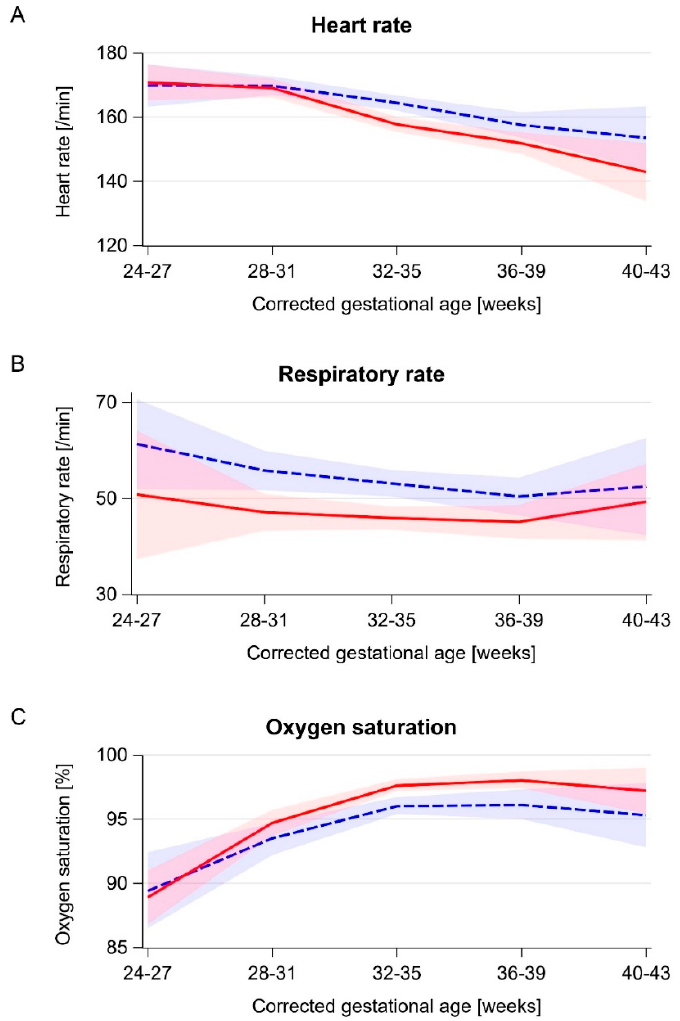
Figure 1. Baseline and post-therapy vital signs by corrected gestational age. Blue dashed line: mean baseline value, red solid line: mean post-therapy value, blue and red bands: corresponding 95% confidence intervals. ( A ) Heart rate. ( B ) Respiratory rate. ( C ) Oxygen saturation.